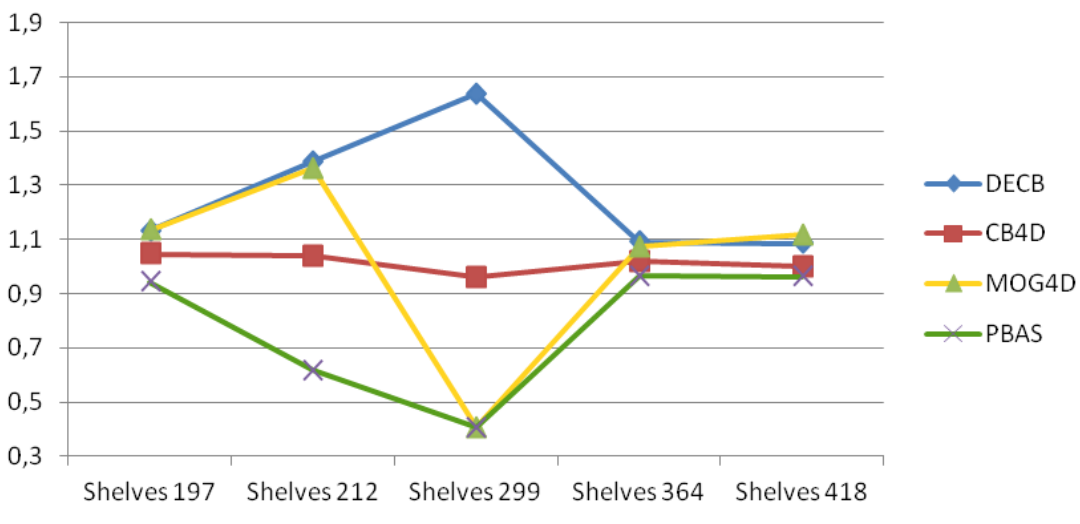
Figure 7. F gain over CB obtained from the test, Shelves. 1